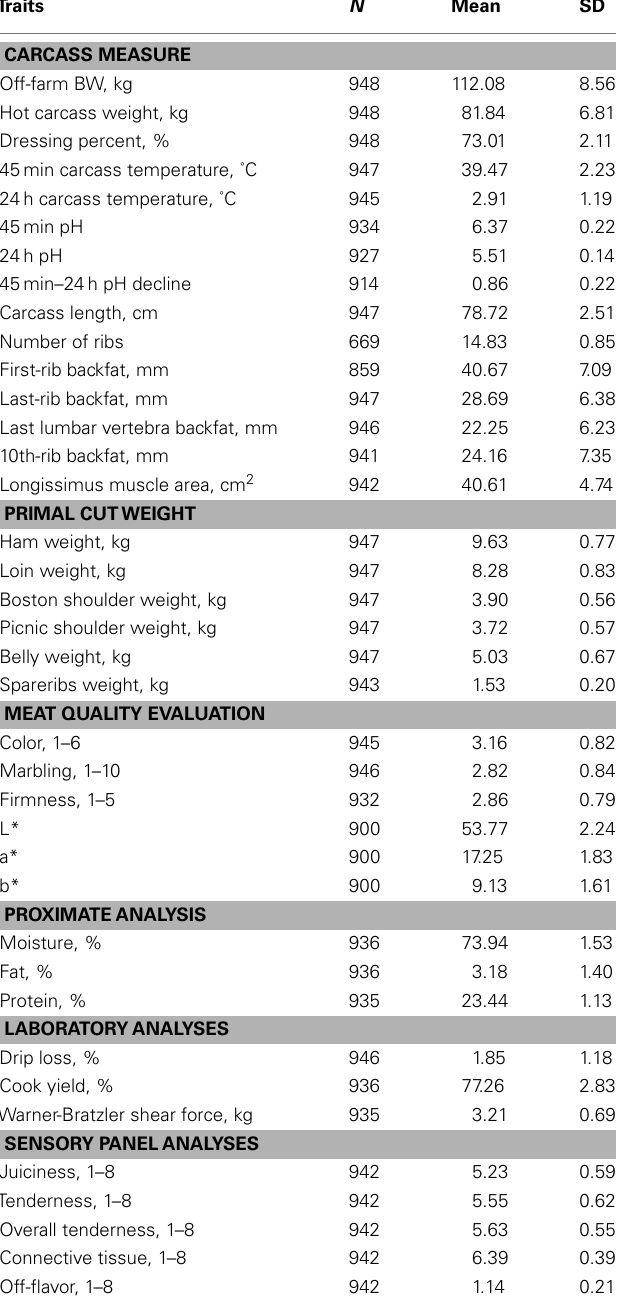
Table 1 | Number of records, means, and SD for carcass and meat quality